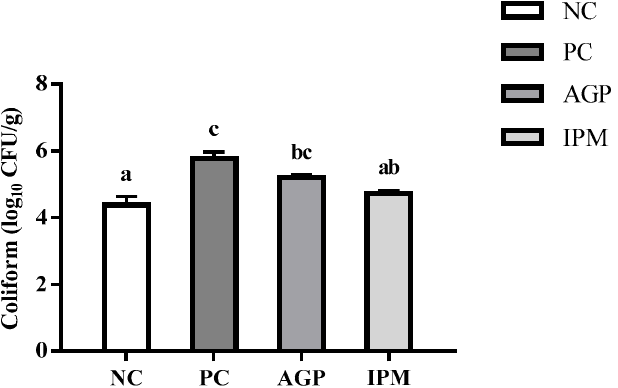
Figure 1. Effect of dietary treatments on fecal coliforms of E. coli K88-challenged weaned pigs. a–c means within a same pattern with no common superscript indicate significant difference between groups ( p < 0.05). Results were presented as log 10 CFU/g feces and as the mean values and the standard error of the mean, ( n = 8). Dietary treatments were as follows: NC, negative control group, basal diet; PC, positive control group, basal diet, and challenged with E. coli K88; AGP, antibiotic growth promoter group, basal diet supplemented with 75 mg/kg chlortetracycline, 50 mg/kg oxytetracycline calcium, and 40 mg/kg zinc bacitracin, and challenged with E. coli K88; IPM, IgY and PM group, basal diet supplemented with IgY at dose of 2.5 g/kg and 1 g/kg and PM at dose of 300 mg/kg and 150 mg/kg during days 1 to 17 and 18 to 42, respectively, and challenge with E. coli